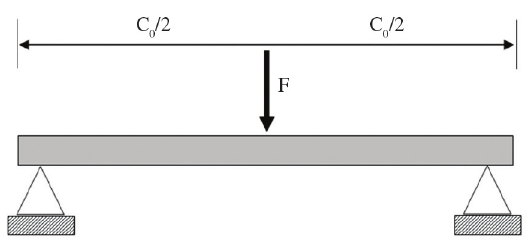
Figure 7. Sketch of the load condition when pushing the coupon against the tool